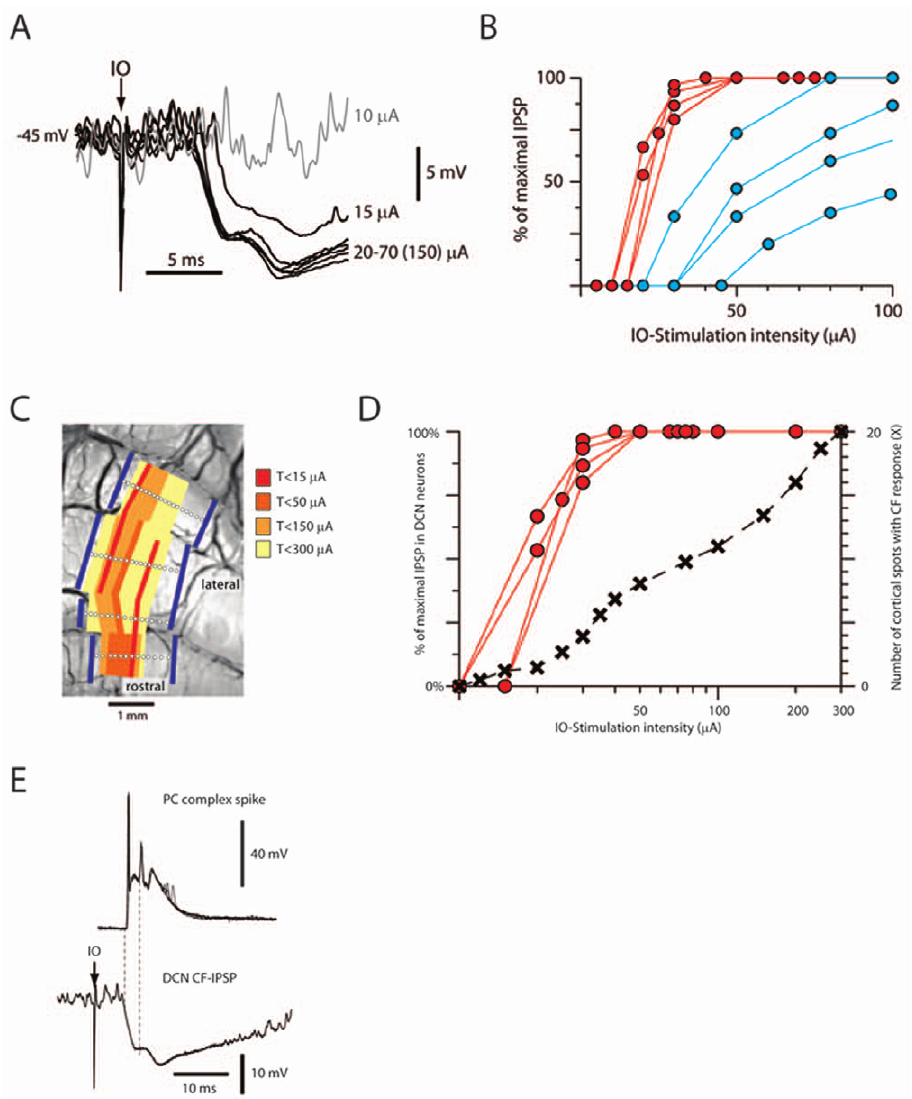
Figure 4. IPSPs evoked in DCN neurons by IO stimulation. (A) Superimposed averages of IPSP responses evoked at different intensities of IO- stimulation in the same DCN cell. Note that even at nearly 10 times the stimulus intensity for evoking a maximal response, the amplitude of the response did not change. The double-peaked nature of the evoked IPSP matched that of the complex spikes in the afferent PCs (see panel E). (B) Stimulus-response curves for DCN cells with low-threshold IO-evoked IPSPs (T , 15 uA, red curves) compared with stimulus-response curves for IO- evoked IPSPs in DCN neurons with higher thresholds (blue curves). (C) Thresholds for cerebellar cortical climbing fiber field responses along the longitudinal axis of different folia of the forelimb area of the C3 zone. The recording sites are indicated on a photograph of the cerebellar anterior lobe sublobules Va-Vc, in which the forelimb area of the C3 zone is located. The borders of the C3 zone are indicated by thick blue lines. The yellow to red coloring indicates the specific thresholds for evoking climbing fiber responses according to the key at left. (D) Comparison between stimulus response curves for low threshold DCN cell IPSPs and the number of cortical spots with evoked climbing fiber responses (data averaged from 5 experiments, indicated by dashed line and crosses). (E) Maximal IO-evoked IPSPs consistently displayed two peaks, separated by about 3 ms (3.4 + / 2 0.7 ms, N=5, analyzed only for cells with identified, low thresholds for IO-evoked IPSPs). The timing of the two peaks of the IPSP paralleled the timing of the first two spikes recorded in the complex spikes from whole cell PC recordings (2.5 + / 2 0.3 ms,